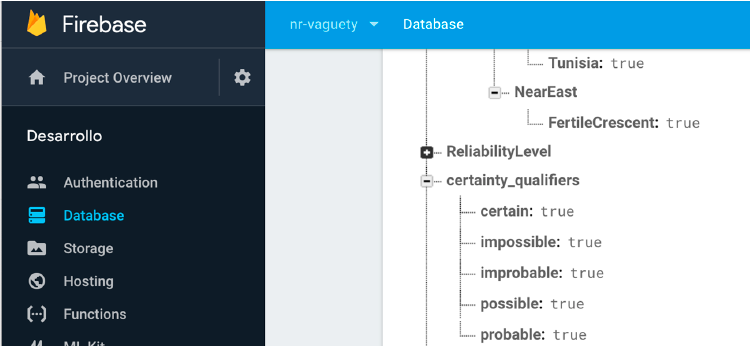
Figure 4. Firebase console showing the data node for defining certainty qualifiers in DICTOMAGRED implementation.